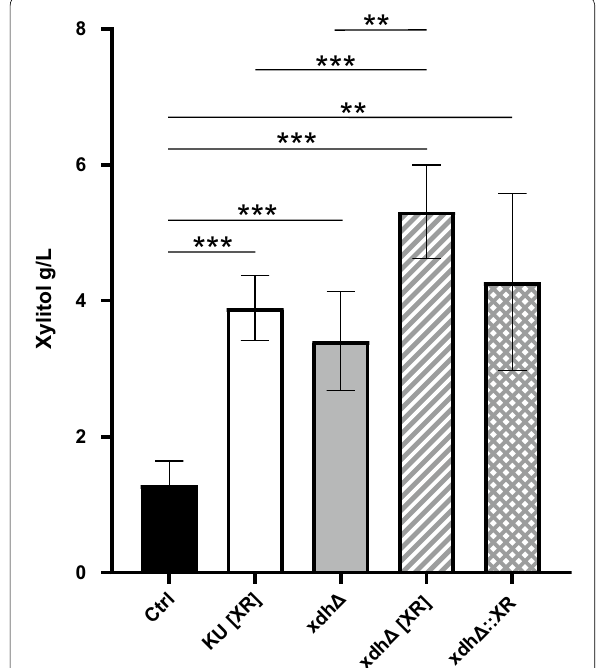
Fig. 5 Xylitol production of M. guilliermondii mutant strains. Xylitol yield (in g l − 1 as determined by HPLC) of KU [EV] (Ctrl); KU [XR]; xdhΔ, xdhΔ [XR] and xdh∆::XR after 72 h cultivation in YNB with 20 g l − 1 xylose and 20 g l − 1 glucose; Displayed are mean values SD of at ± least 3 replicate experiments, each performed in triplicates. Asterisks indicate p-values (** p < 0,005 and *** p = =